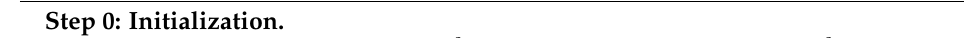
Algorithm 1 DFTR